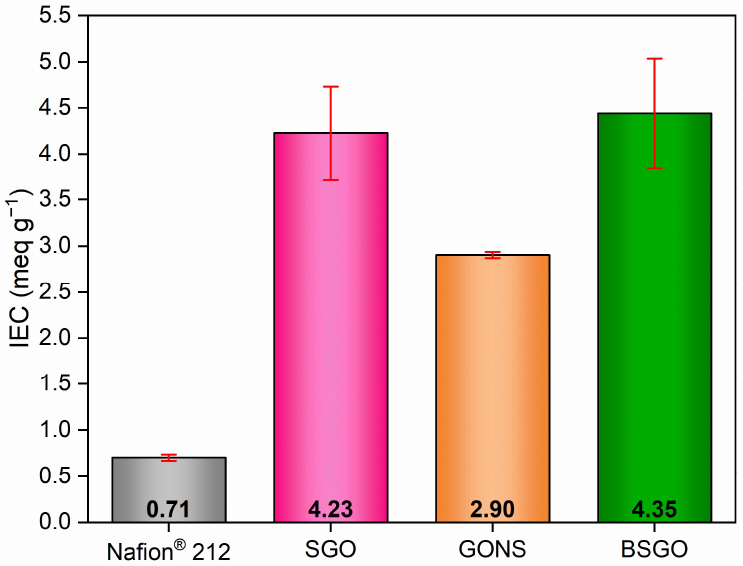
Figure 5. Ion exchange capacity of the proposed GO-based membranes compared with Nafion ® 212.